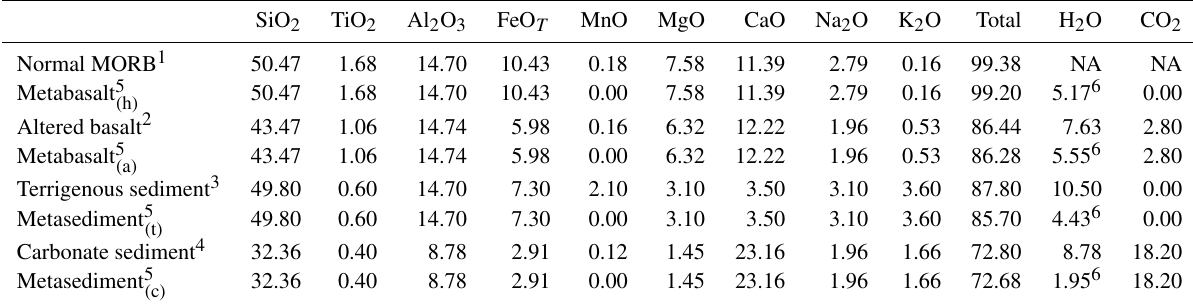
Table 1. Bulk compositions used for the